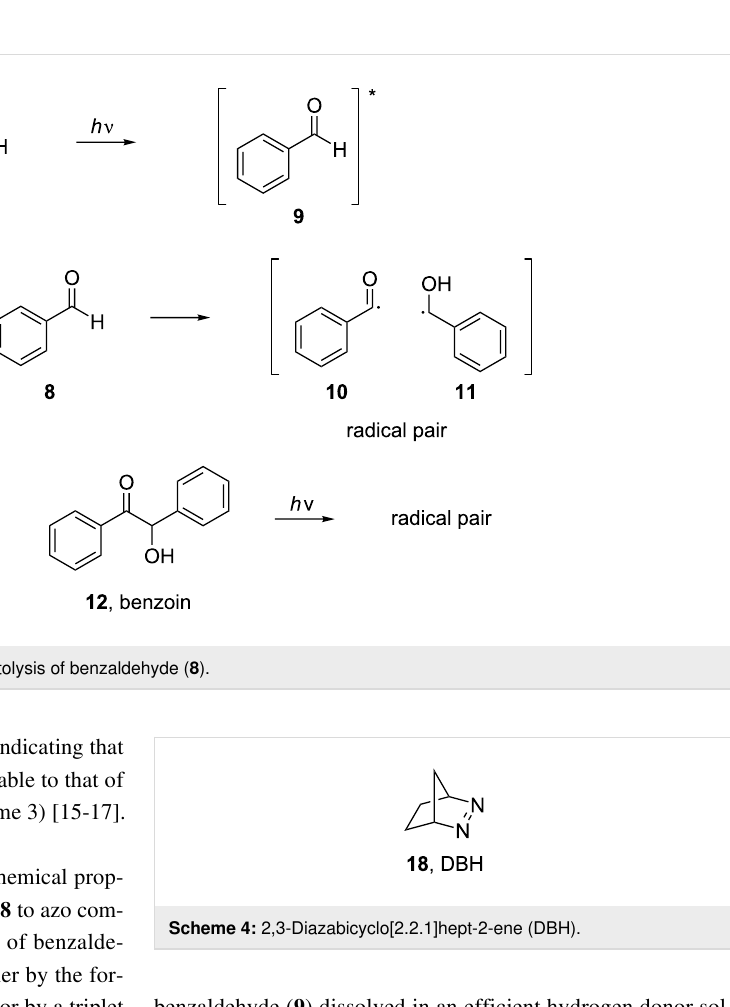
benzaldehyde ( 9 ) dissolved in an efficient hydrogen donor sol- vent can lead to an α -hydroxybenzyl radical ( 11 ) as the only detectable species, which will rapidly react with the solvent. In nondonating solvents, such as hexane, triplet state benzalde- hyde ( 9 ) reacts with ground state benzaldehyde ( 8 ) to form a radical pair of a benzoyl radical ( 10 ) and an α -hydroxybenzyl radical ( 11 ). The formation of benzoin ( 12 ) was also detected in solvents that did not react with the excited benzaldehyde ( 9 , Scheme